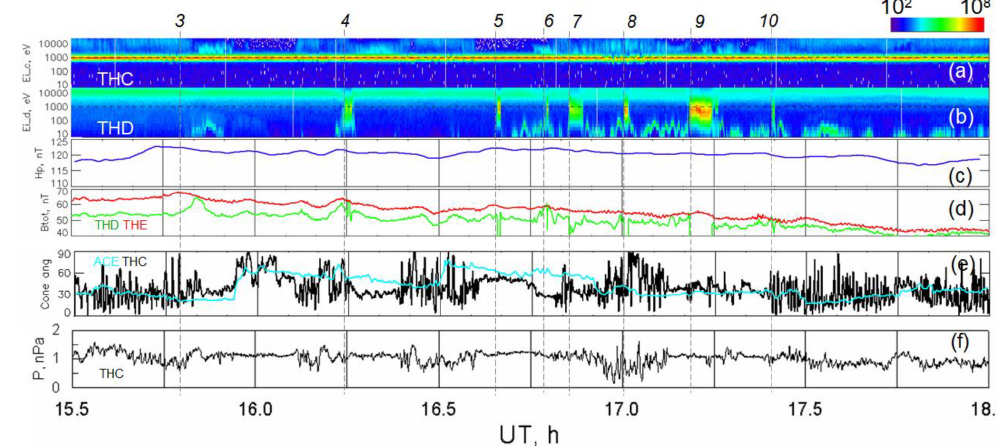
Figure 7. Observations of the plasma and magnetic field at 15:30–18:00UT on 1 August 2008: (a, b) ion spectrograms measured by TH- C, TH-D (ion flux is in units of eVcm − 2 ssreV), (c) horizontal magnetic field Hp detected by GOES-12 from 10 to 13LT, (d) magnetic field strengths Btot from TH-D (green) and TH-E (red), and (e) IMF cone angles for TH-C (black) and the ACE upstream monitor (blue). (f) TH-C solar wind dynamic pressure. Dashed lines and numbers 4–10 mark plasma structures of magnetosheath ions observed inside the